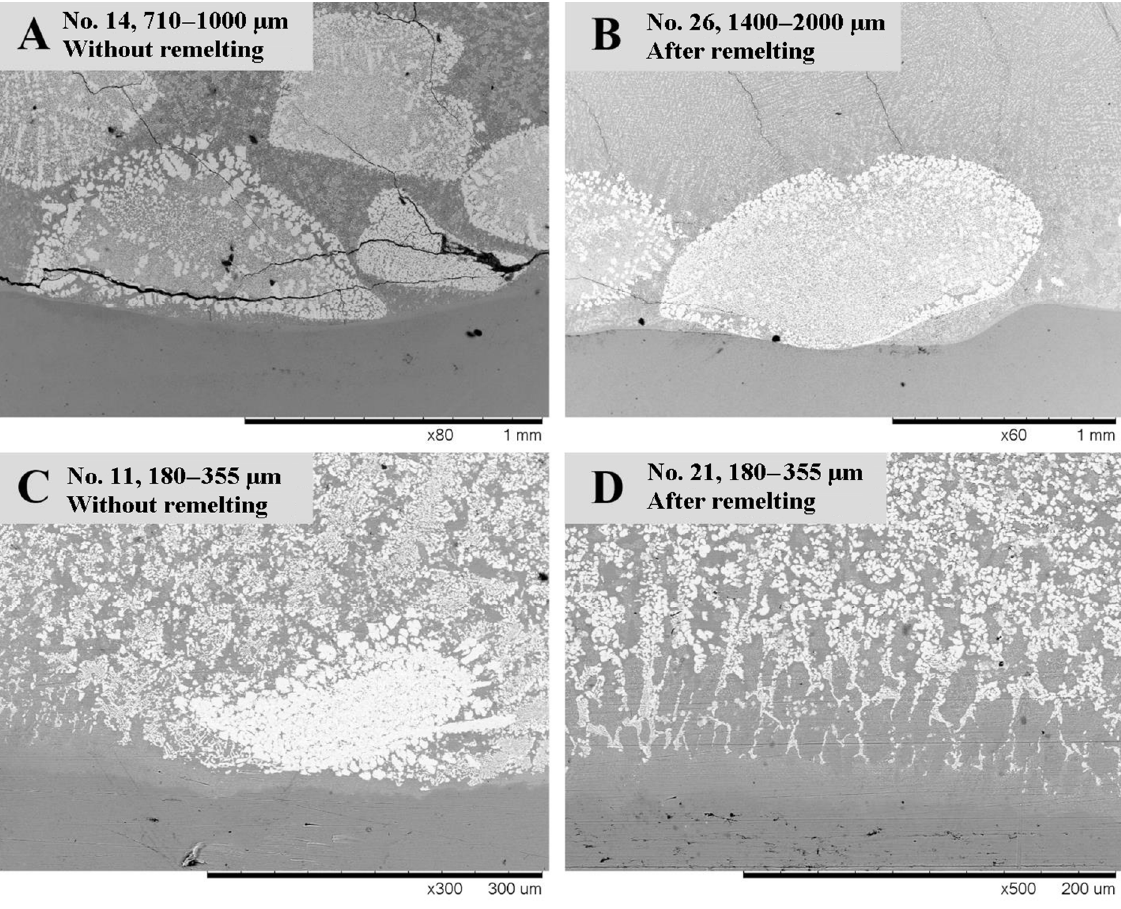
Figure 4. WC particle size variation without remelting ( A , C ) and after remelting ( B , D ): ( A ) sample No. 14 (700–1000 µm), ( B ) sample No. 26 (1400–2000 µm), ( C , D ) samples No. 11 and 21 (180–350 µm).